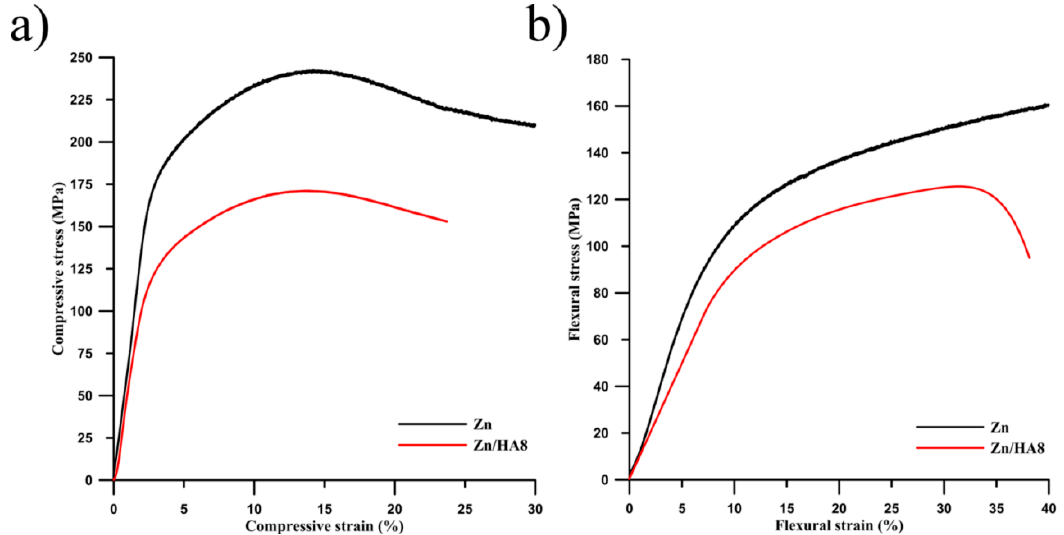
Figure 5. Engineering ( a ) compressive and ( b ) flexural curves of the extruded Zn and Zn/HA8 Figure5. Engineering( a )compressiveand( b )flexuralcurvesoftheextrudedZnandZn / HA8composite. composite.